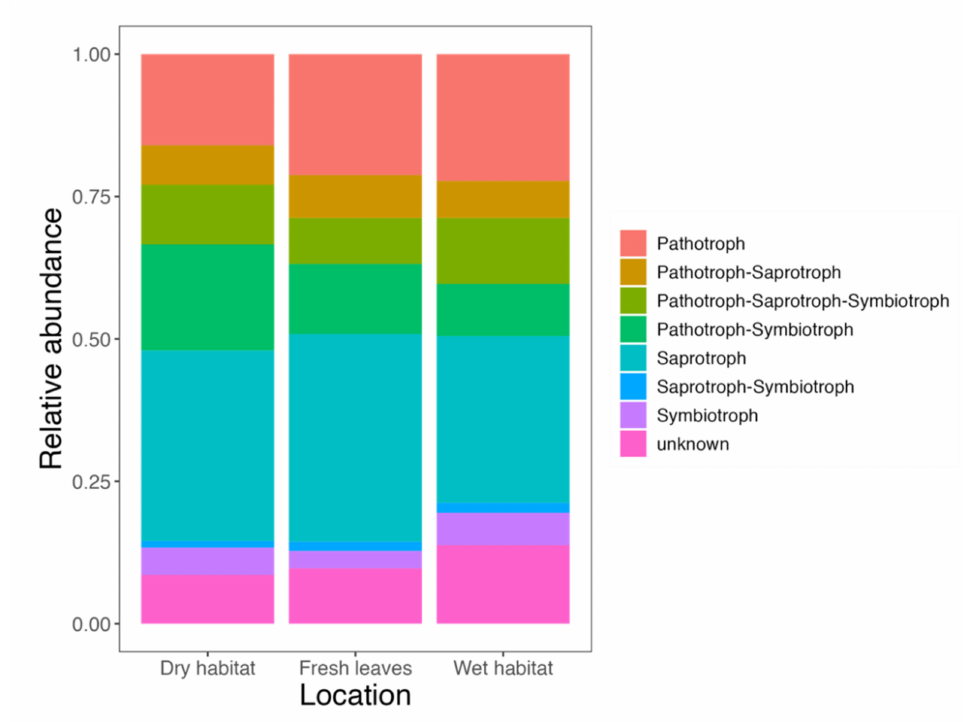
Figure 2. Bar charts showing the trophic guilds of fungal communities in fresh leaves and leaves decomposing in wet or dry habitat. Undefined category combines fungal genera without assigned trophic